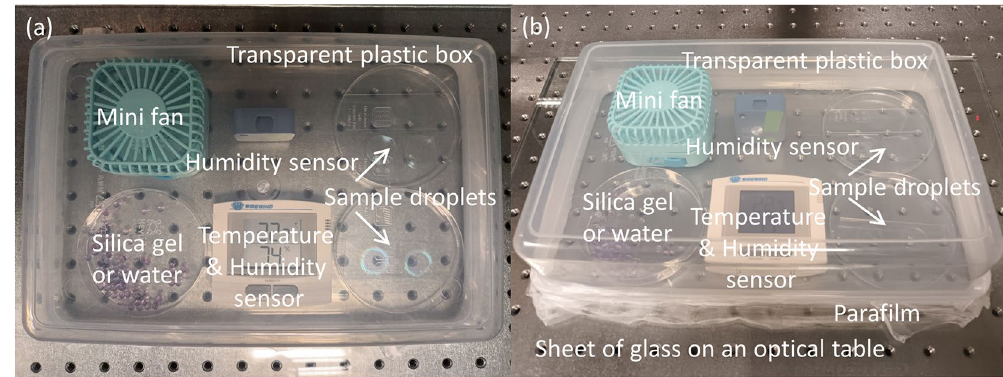
Figure 1. ( a ) Top and ( b ) side views of our typical setup for preparing CNC droplet films under humidity- controlled drying. Two humidity sensors were used to increase